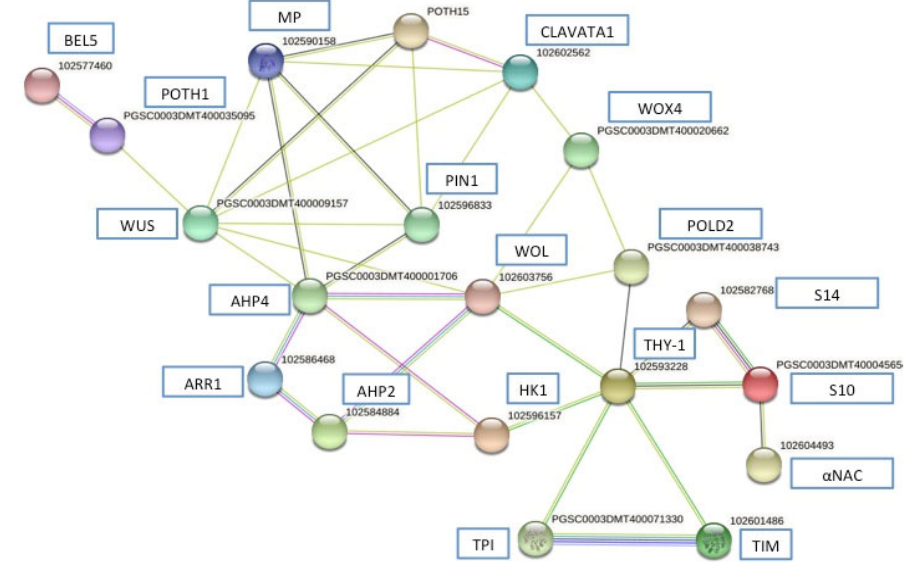
Figure 2. Gene network derived from STRING database of potato S. tuberosum (0.500 confidence) analyzed using qPCR. Homologous sequences of A. thaliana are written in rows. Numbers in the bubble indicate the gene identifier of each gene derived from the potato genome. The figure represents a full network, the edges indicate both functional and physical protein associations.